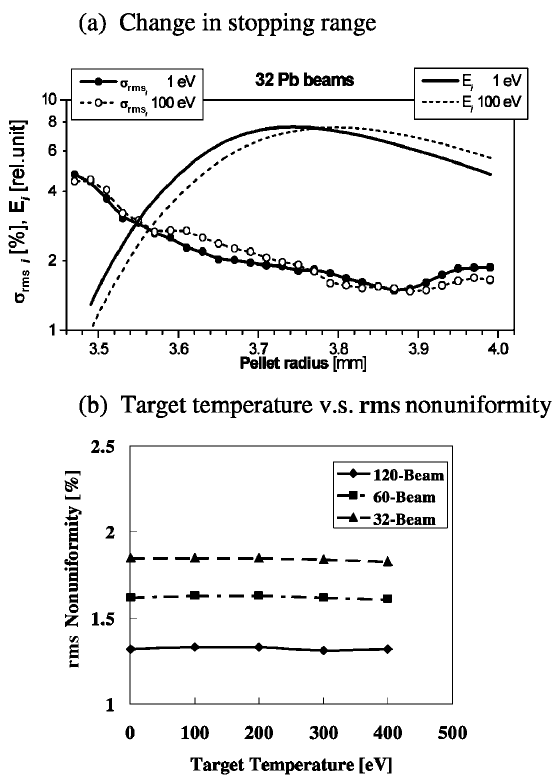
FIG. 15. (a) The deposition energy of beam particles and rms nonuniformity at each surface in the case with the beam temperature effect and target temperature (1 and 100 eV) for the Al layer target, the chamber radius of 5 m, 32-beam system, and the semi-Gaussian distribution. (b) The rms non- uniformity versus the target